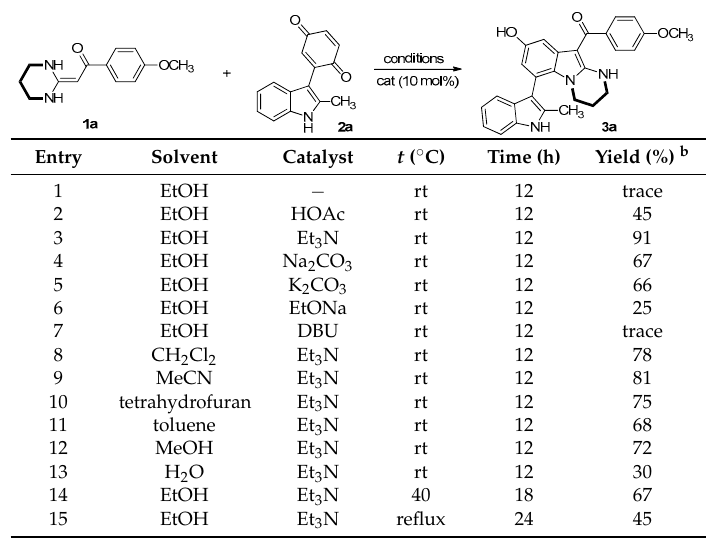
Table 1. Optimization of reaction conditions a .